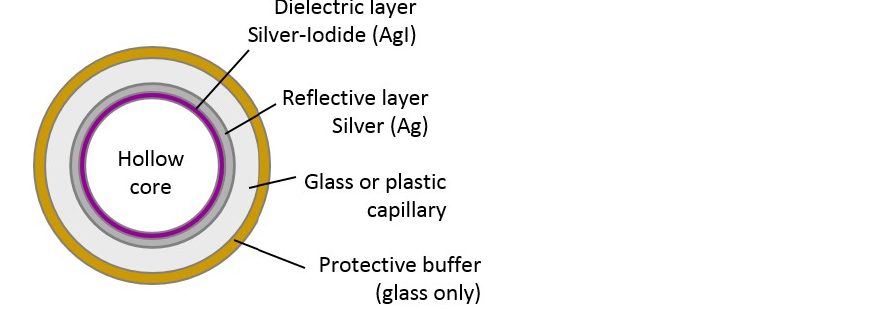
Figure 3. Conceptual scheme of the 10 cm-path gas cell tailored for measuring regasified LNG sam- ples. Table 1. Some common gas cell window materials and their transmission working range [27–29] (there may be slight discrepancies in the wavenumbers among the references). Window Material